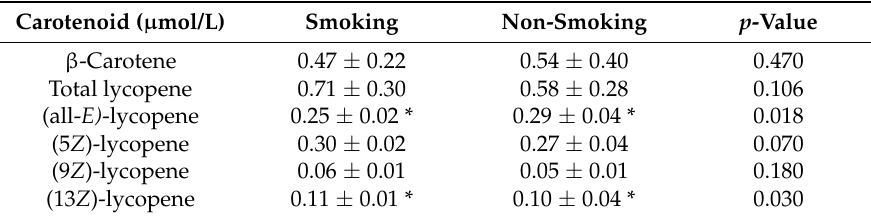
Table 2. Levels of β -carotene and lycopene in plasma isolated from smoking and non-smoking participants ( n = 52 ± SD) determined by HPLC. * indicates significant differences between smokers and non-smokers ( p <